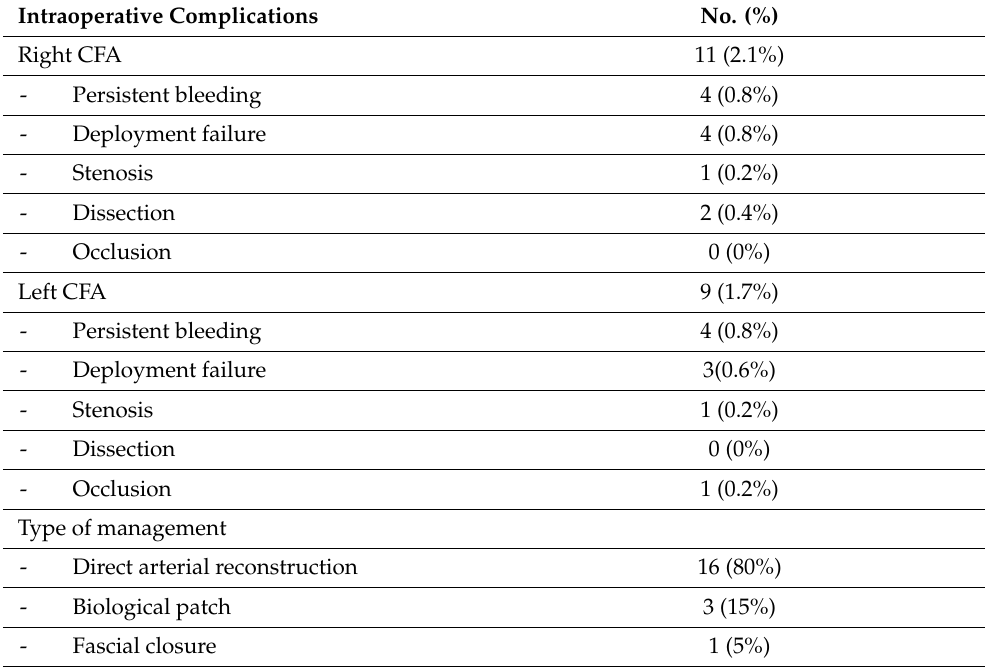
Table 3. Intraoperative complications requiring femoral exposure in relation to site access location and type of management. No. = number; CFA = common femoral artery.